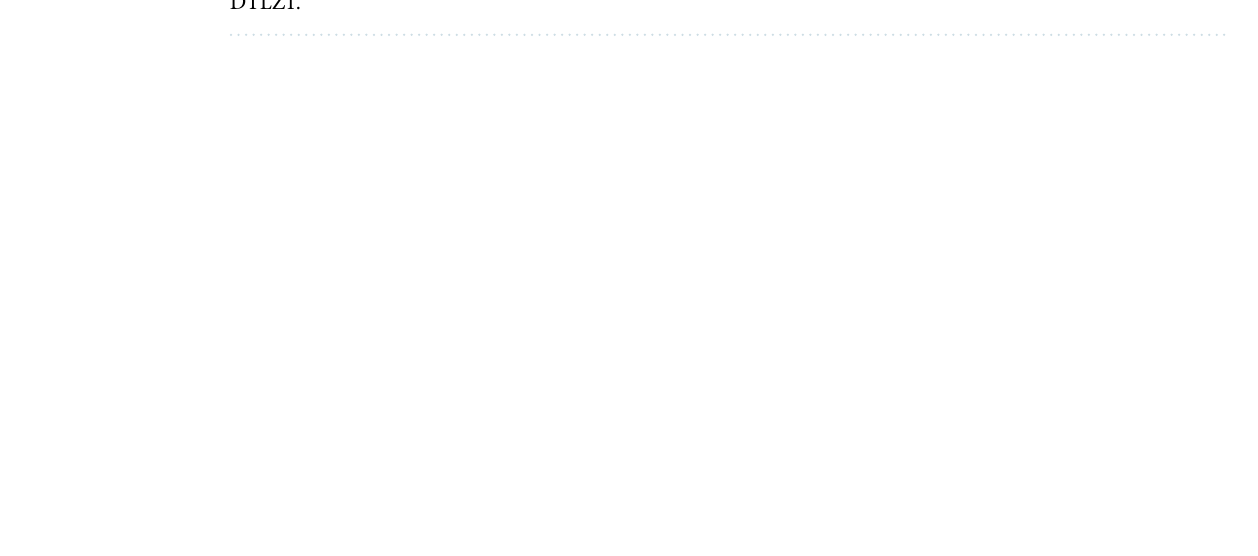
Figure 4. Parallel coordinates of the best solution set of PMEA, I SDE + and HS-MOEA on 8-objective instance of